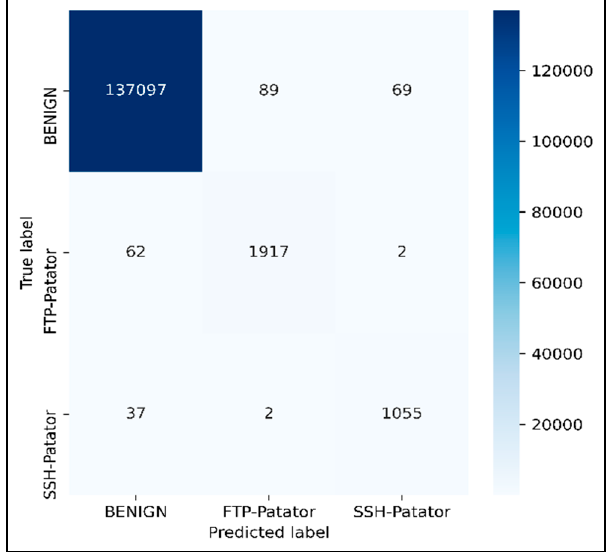
Figure 7. Confusion matrix.